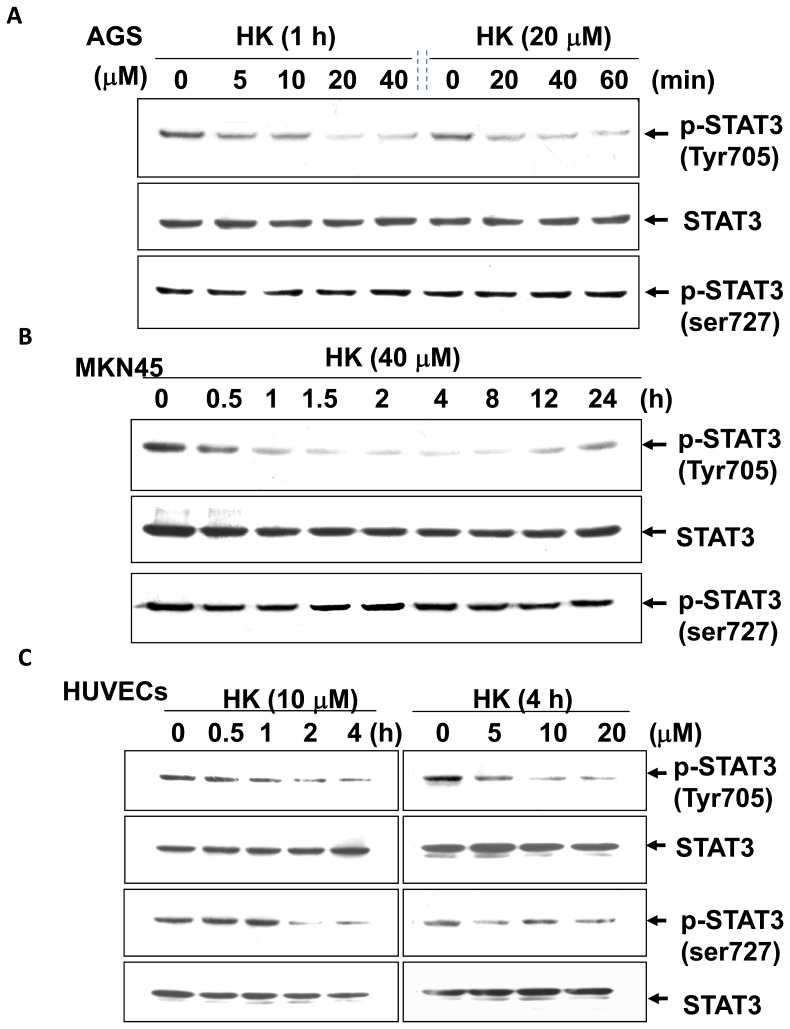
Effect of honokiol on STAT-3 phosphorylation in gastric cancer cells and HUVECs.AGS (A) and MKN45 (B) quiescent human gastric cancer cells and HUVECs (C) were treated with and without honokiol (HK, 5–40 µM) for the indicated times. Whole cell lysates were prepared and analyzed by Western blotting for detection of phosphorylated STAT-3 (pSTAT-3, Tyr705). The blottings were reprobed with anti-STAT-3 antibodies for normalization. The results are representative of at least five independent experiments.